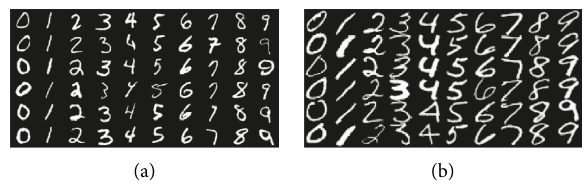
Figure 3: Image samples from (a) MNIST and (b) USPS.